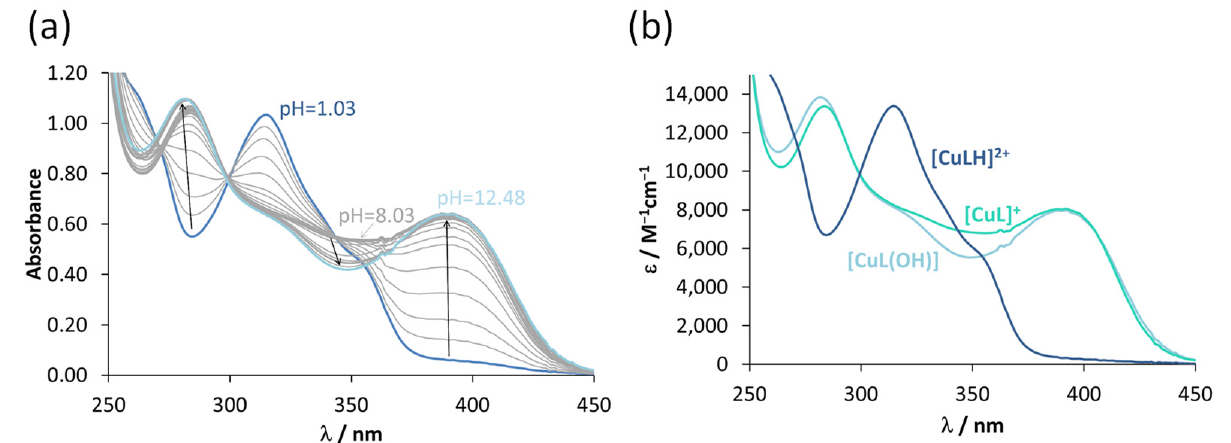
Figure 4. ( a ) UV - vis spectra of the copper(II)–COTI-NH 2 (1:1) system recorded at various pH values and ( b ) calculated individual molar absorption spectra; c Cu(II) = c L = 80 µM, pH = 1.0–12.5, T = 25 °C, I = 0.10 M (KCl), ℓ = 1.0 cm, and 30% ( v/v ) DMSO/H 2 O. Table 3. p K a values and conditional and overall stability constants (log β 5.9 (cid:48) and log β ) for the copper(II) and zinc(II) complexes, and formal redox potentials ( E (cid:48) ) for the copper(II)–ligand (1:1) systems. COTI-2 COTI-NH 2 COTI-NMe 2